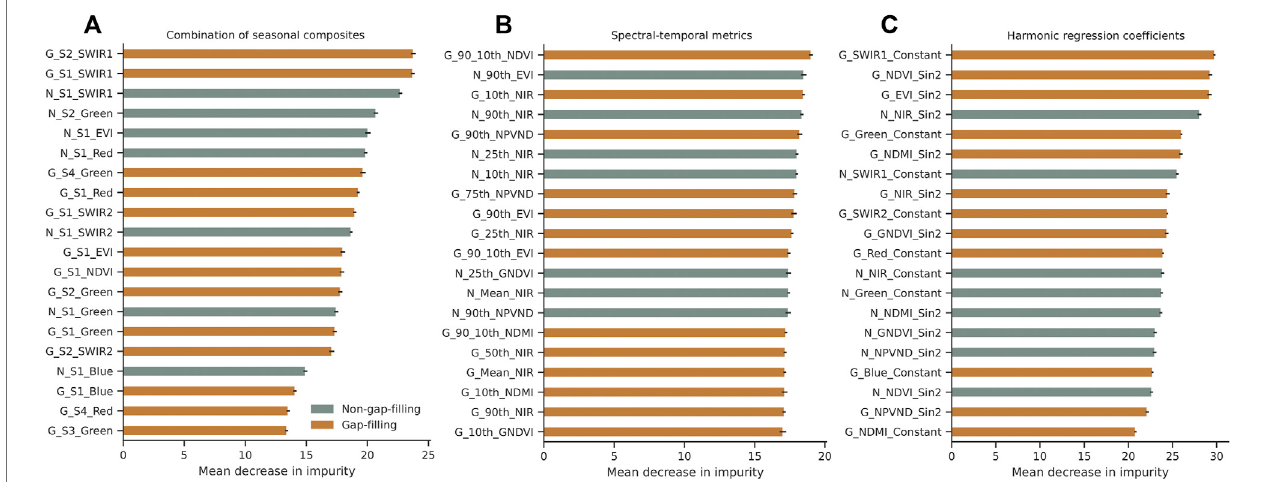
FIGURE 8 | Top 20 variable importance measured by mean decrease in accuracy from random forest models using three types of variable predictors: (A) combination ofmultiSCs, (B) STMs, and (C) HR coef fi cients.Variablesthatdonothavegap- fi llingapplied startwith “ N ” whilevariablesthathave MOPSTMgap- fi lling applied start with “ G ” . The importance scores are the mean values for 100 iterations.